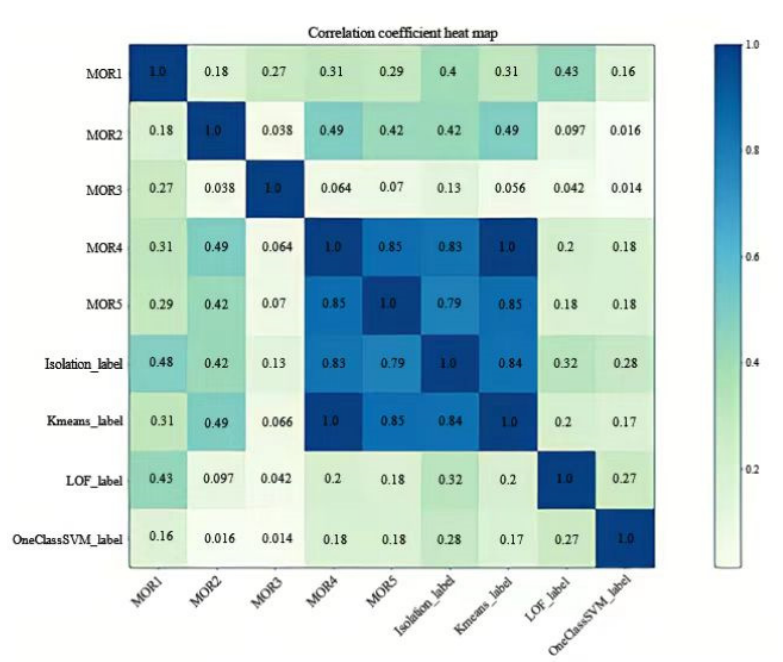
Figure 5. The Heat map of Correlation coefficient.